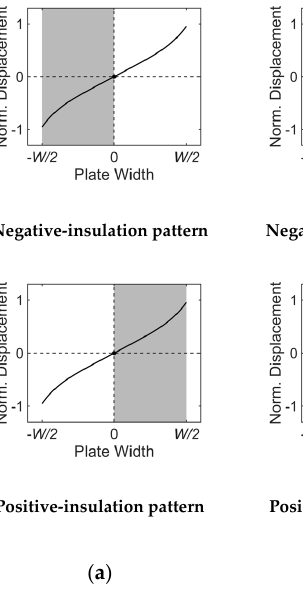
Figure 5. Acoustically insulated regions for anti-symmetric width modes: ( a ) A(0,1), ( b ) A(0,3), ( c ) A(0,5) modes; the shadowed are acoustically insulated regions.